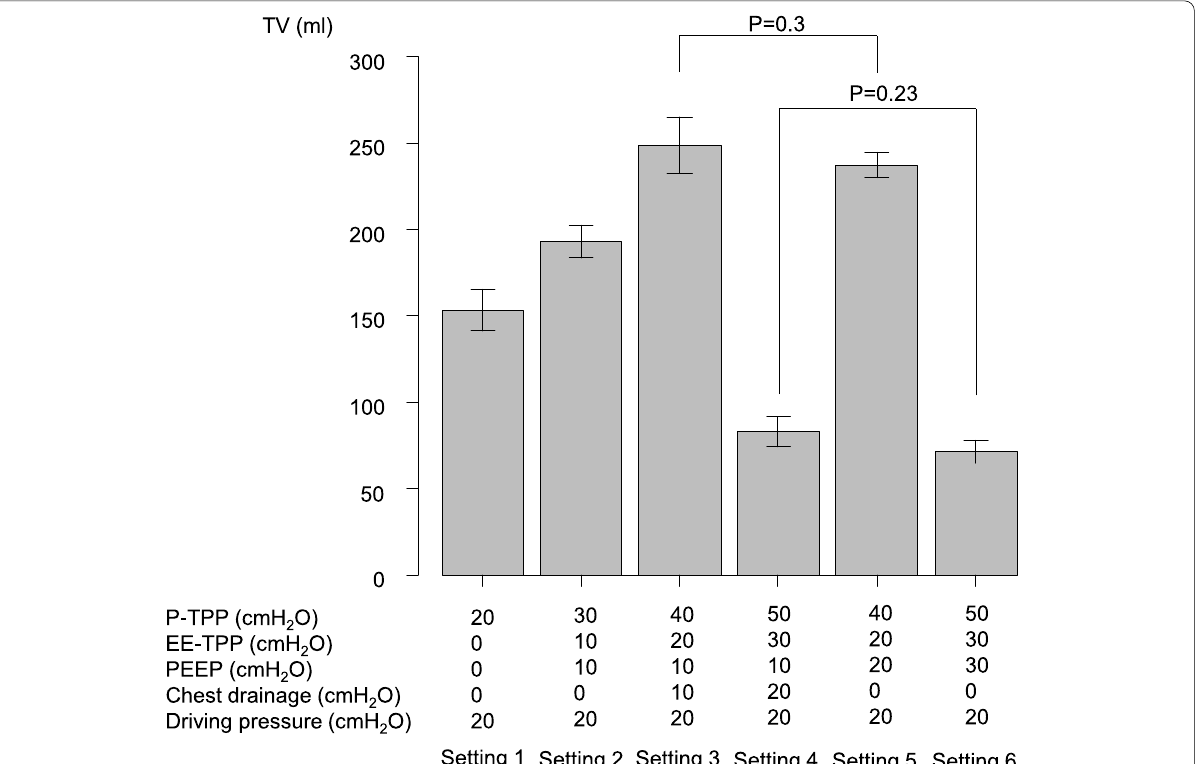
Fig. 3 Experimental results. PEEP, positive end-expiratory pressure; P-TPP, peak transpulmonary pressure; EE-TPP, end-expiratory transpulmonary